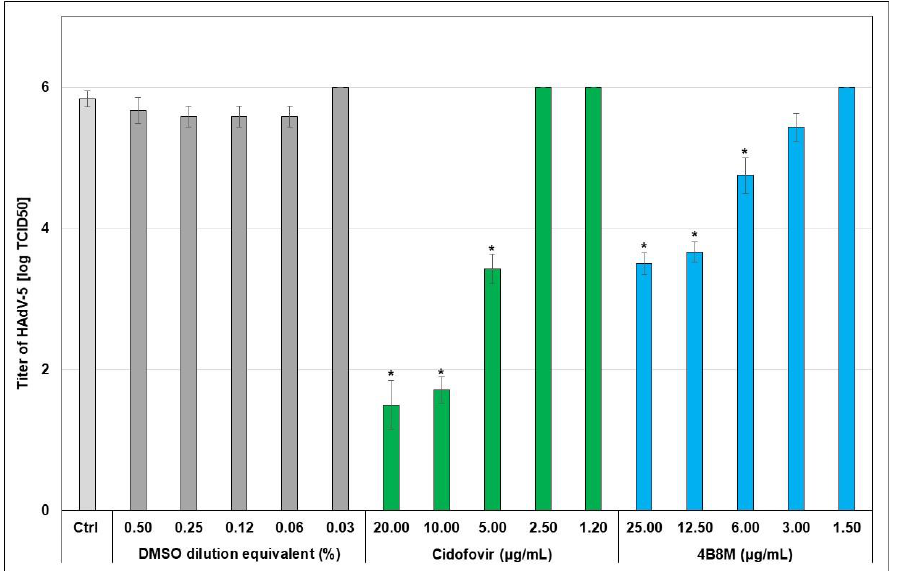
Figure 4. The effect of 4B8M on HAdV-5 replication in A-549 cells. A-549 cells were infected with HAdV-5 of MOI = 1 and, after 1 h of virus absorption at 37 °C, the virus inoculums were removed and the infected cells were incubated for 48 h with the peptide (25; 12.5; 6.2 and 3.1 μg/mL) or DMSO as the solvent control for 4B8M or in medium only (Ctrl). Cidofovir (20.0; 10.0; 5.0; 2.5 and 1.2 μg/mL) was used as a reference drug. The viral titer was expressed with reference to the TCID50 value, which is based on the cytopathic effect caused by this virus in approximately 50% of infected cells. The results, obtained from 4 independent experiments (mean ± SE), are presented as the logTDIC50 values in relation to appropriate DMSO control. * p < 0.05 as compared with appropriate controls.